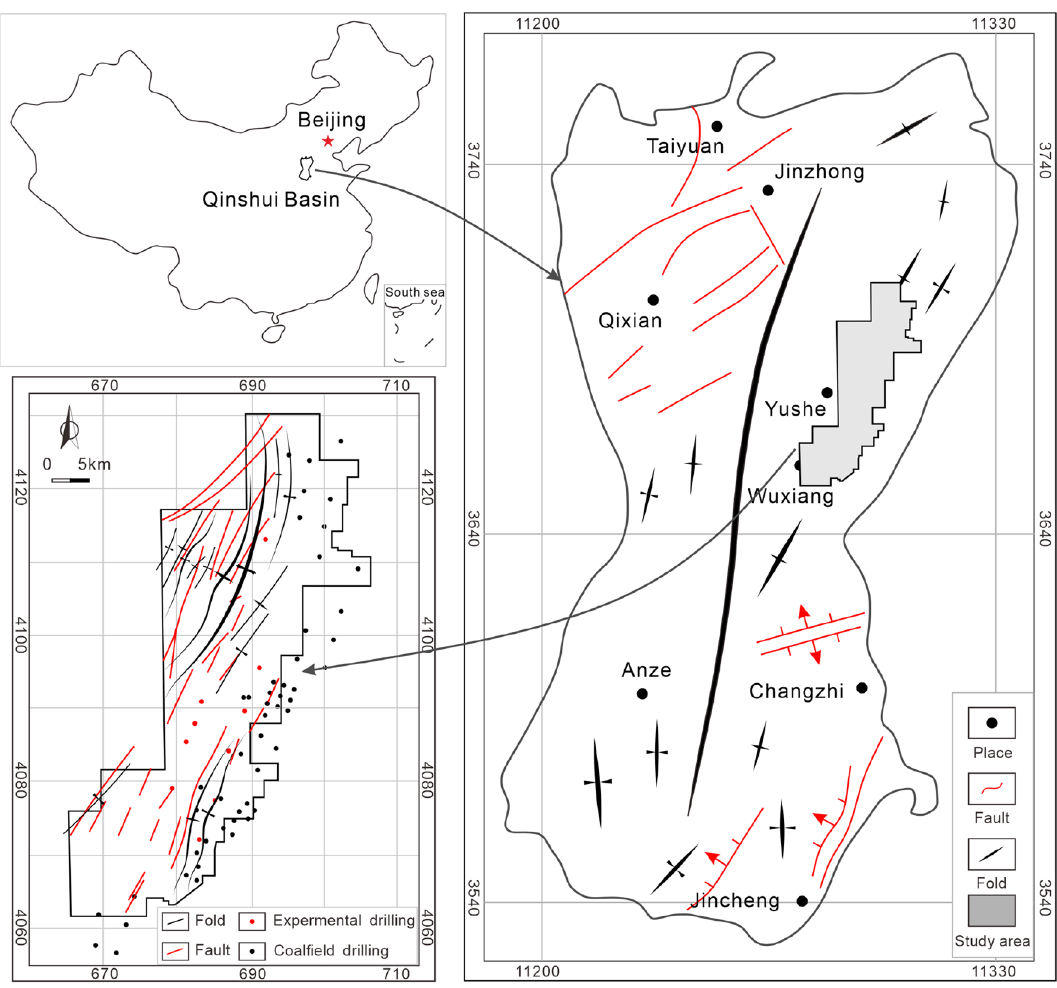
Figure 1. The tectonic location and structural characteristics of the Yushe-Wuxiang Block, modified from Ref. 3,53 .